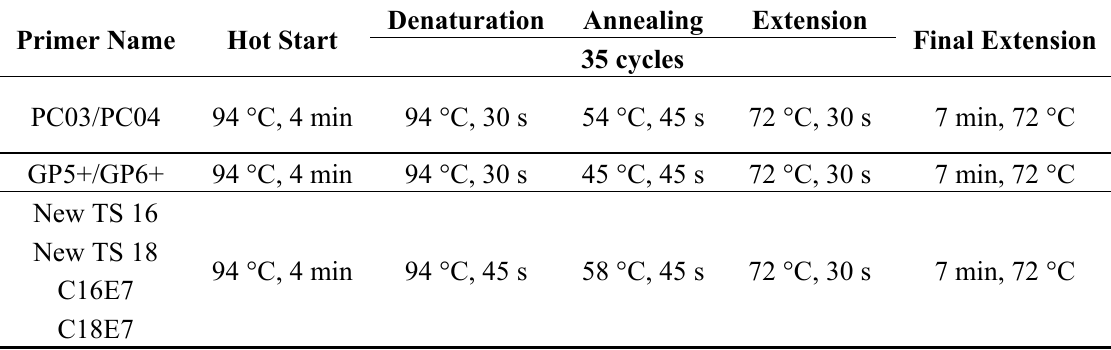
Table 2. Polymerase chain reaction (PCR) conditions for individual primer